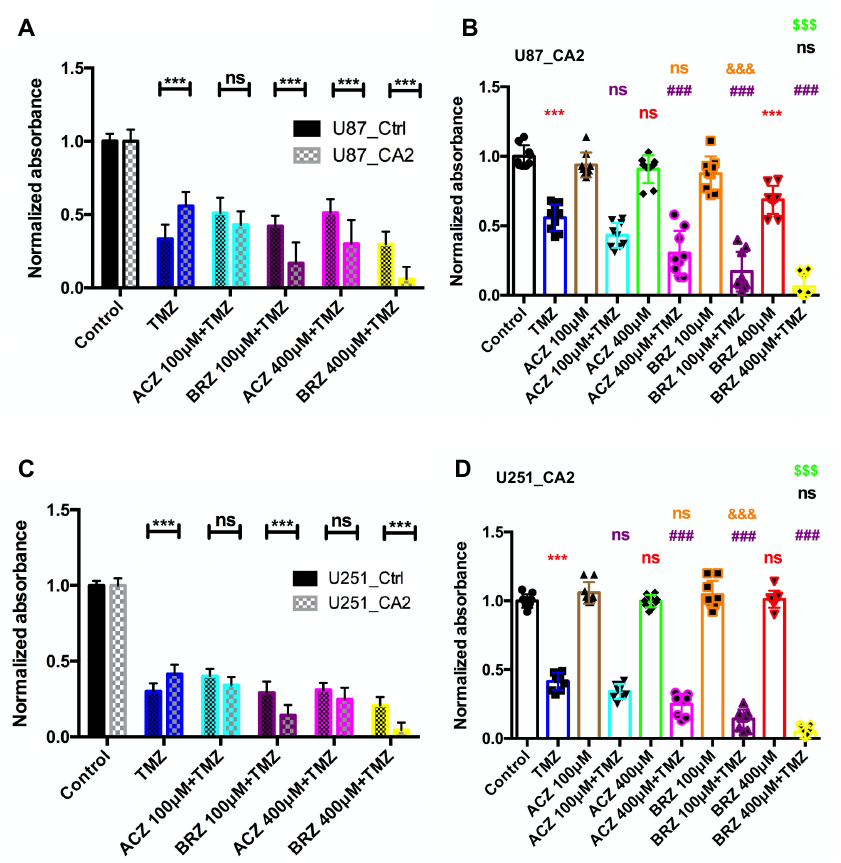
Figure 4. Effect of combined treatment with TMZ and either ACZ or BRZ on CA2 overexpressing GBM cell lines U87 and U251. ( A ) Co-treatment with 500 µ M TMZ and ACZ/BRZ on U87_Ctrl cells and U87_CA2 cells for 5 d. U87_CA2 cells significantly decreased cell viability compared to U87_Ctrl cells after BRZ + TMZ treatment. However, only 400 µ M ACZ + TMZ decreased cell viability compared to the U87_Ctrl group ( n = 3). ( B ) In U87_CA2 cells treated with TMZ, ACZ/BRZ, or TMZ + ACZ/BRZ, TMZ plus 400 μ M ACZ decreased the viability compared to TMZ alone. However, 100 μ M ACZ in combination with TMZ did not change the cell viability. Both 100 μ M and 400 μ M BRZ in combination with 500 μ M TMZ decreased the viability significantly compared to TMZ treatment alone ( n = 3). ( C ) Co-treatment with 30 μ M TMZ and ACZ/BRZ on U251_Ctrl cells and U251_CA2 cells for 5 d. U251_CA2 cells decreased cell viability compared to U251_Ctrl cells after 400 μ M BRZ + TMZ treatment. However, ACZ + TMZ did not change cell viability compared to the U251_Ctrl group ( n = 3). ( D ) In U251_CA2 cells, ACZ/BRZ has no cytotoxic effect, TMZ plus 400 μ M ACZ decreased the viability compared to TMZ alone. Both 100 μ M and 400 μ M BRZ in combination with 500 μ M TMZ decreased the viability significantly compared to TMZ treatment alone ( n = 3). * (Red): compared to Control group; # (Purple): compared to TMZ group; & (Orange): compared to ACZ 100 μ M + TMZ group; % (Black): compared to BRZ 100 μ M + TMZ group; $ (Green): compared to ACZ 400 μ M + TMZ group. Results were obtained from 3 independent experiments. Data are presented as mean ± SD, Two-way ANOVA was used to analyze ( A , C ), One-way ANOVA was used to analyze ( B , D ), ***, $$$, &&&, ###, p < 0.001, ns: not significant. Together, these data confirm that BRZ in combination with TMZ is more effective than the pan-CA inhibitor ACZ. However, this needs to be demonstrated on GSCs, as this cell type is a major source of TMZ therapy resistance in GBM. Therefore, to analyze the possibility that CA2 induced by TMZ could cause chemoresistance, we first evaluated the mRNA expression of CA2 in three independent patient-derived GSC lines after stimulation with TMZ and determined CA2 expression levels by qPCR (Figure 5A–C). After stimulating the GSCs with 500 μ M TMZ for 3 d and 5 d, expression of CA2 was